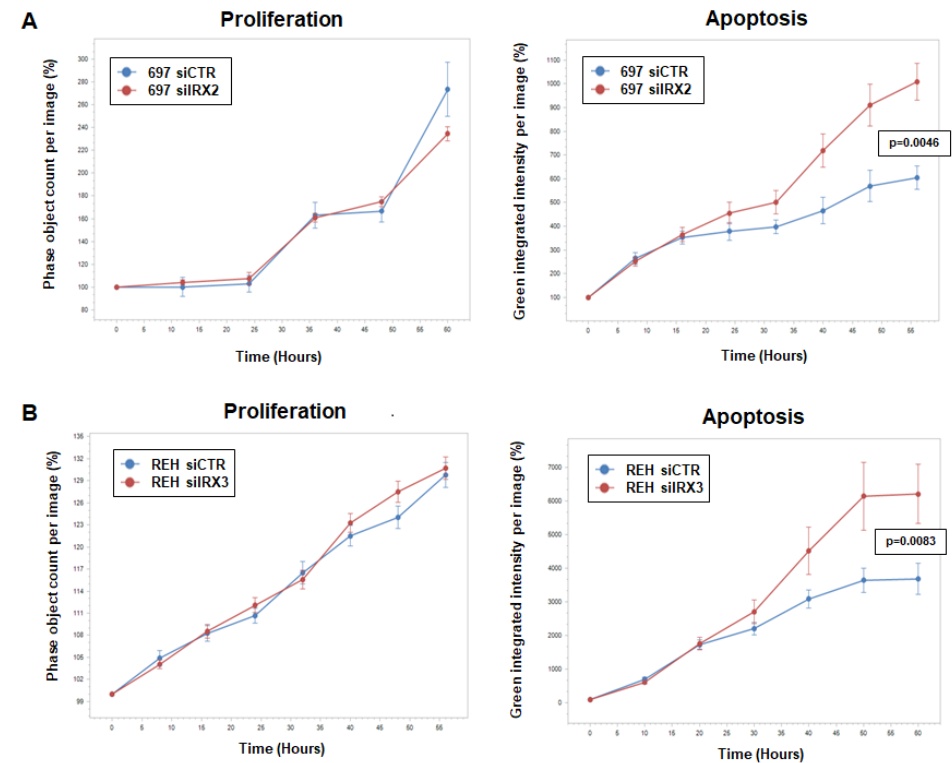
deregulated IRX genes operate anti-apoptotically in BCP-ALL.